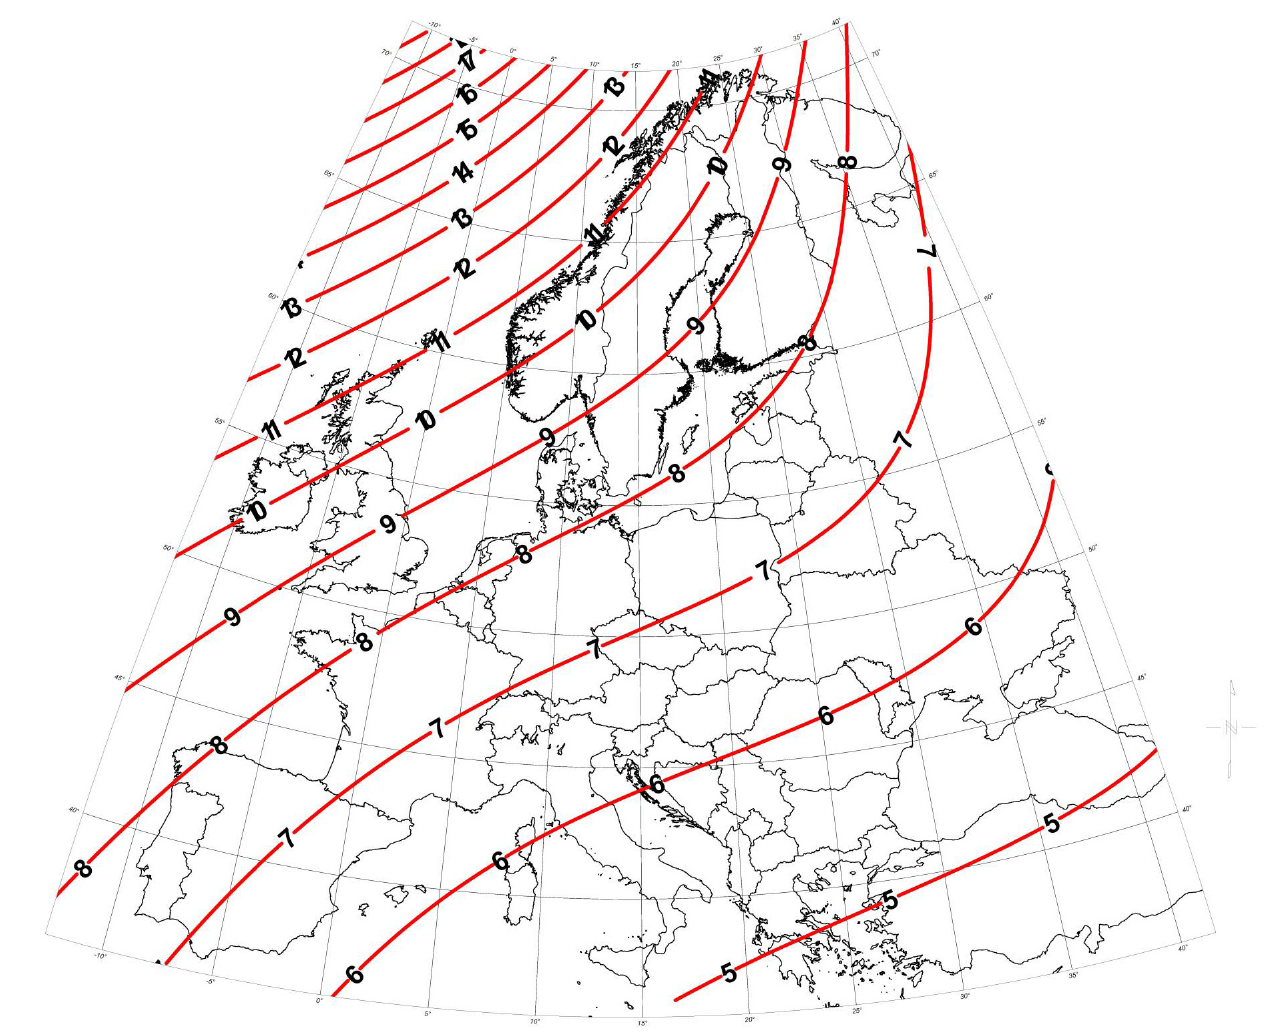
Figure 7. Annual change of declination (minutes/ per year): map of the annual change ('secular variation') of the magnetic declination in